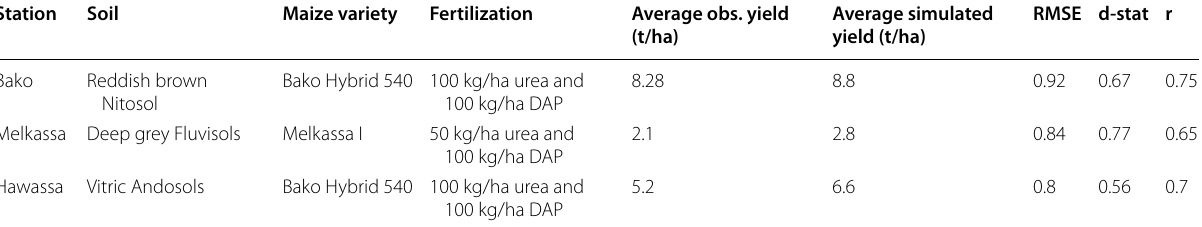
Table 4 Model capacity to represent local systems